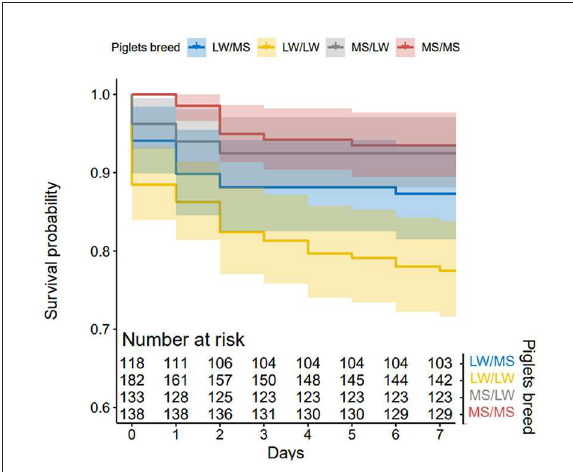
FIGURE5 Kaplan-Meier curves of piglet mortality after farrowing for the four piglet genetic types (dam breed/sire breed).